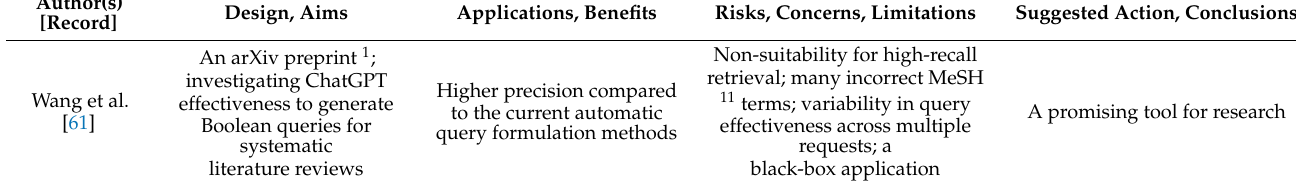
Table 3. A summary of the main conclusions of the included records representing